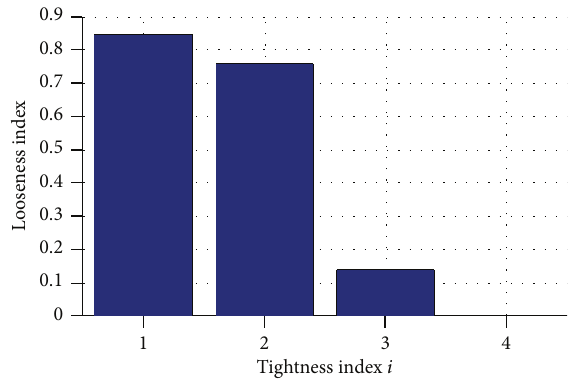
Figure 8: Looseness index (PZT 3 as actuator and PZT 1 as sensor).